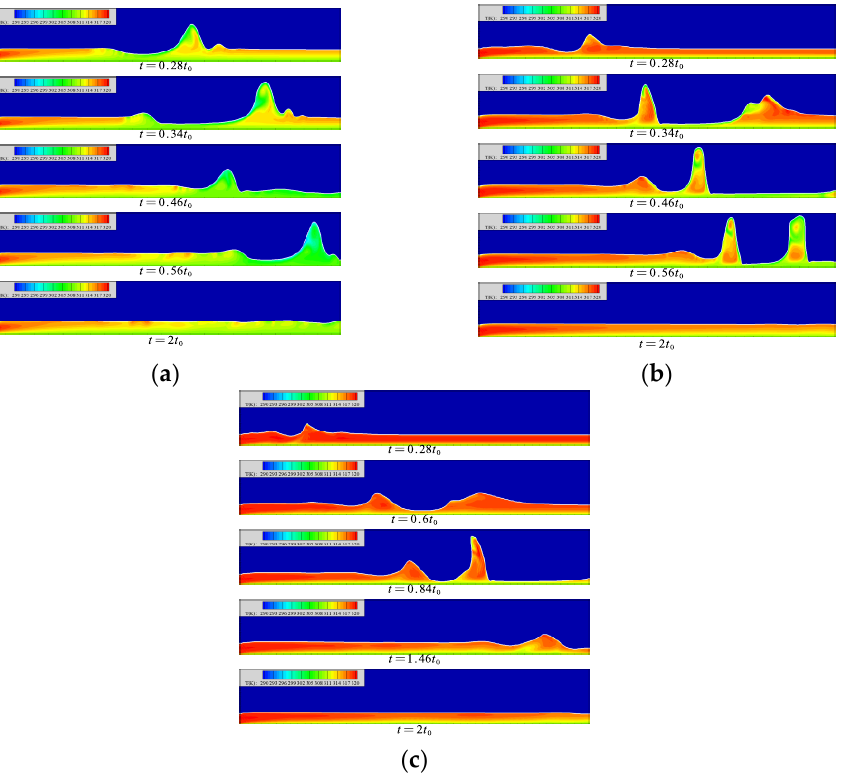
Figure 8. The temperature distribution in the liquid film at each moment. ( a ) Re = 5, ( b ) Re = 20, ( c ) Re = 40.